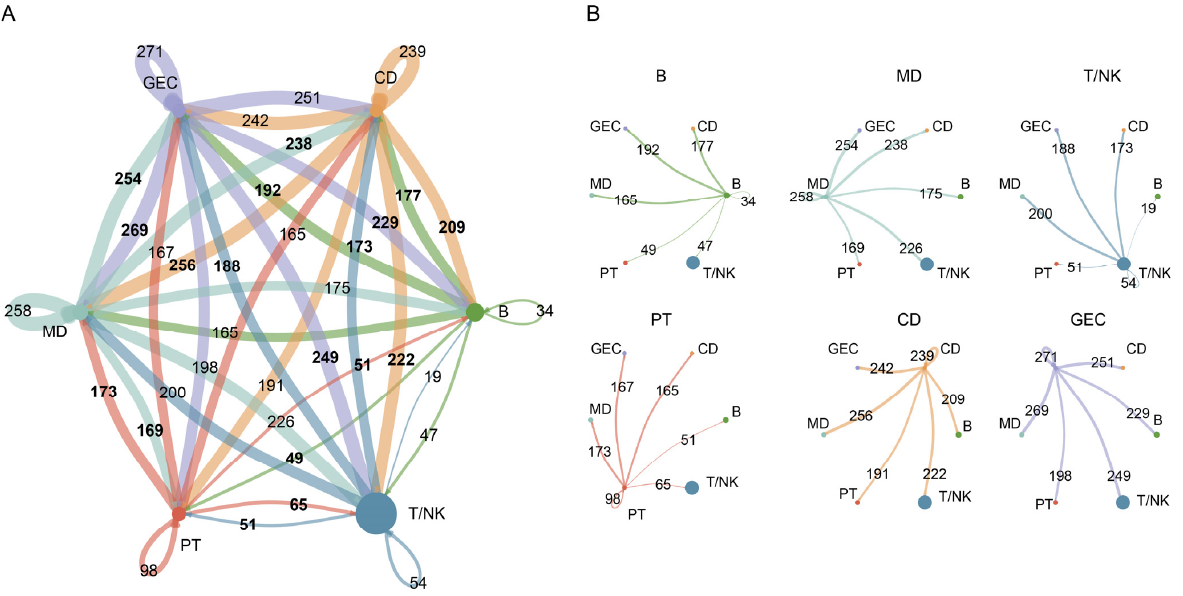
Figure 6. Cell–cell communication network in BKPyV-infected kidneys immune microenvironment. ( A ) The number of interactions between any two cell types using a circle plot. The edge colors were consistent with the sources as senders, and edge weights were proportional to the interaction count. ( B ) Detailed view of the number of interactions sent from each cell type. Numbers indicated the quantity of ligand–receptor pairs for each intercellular link.